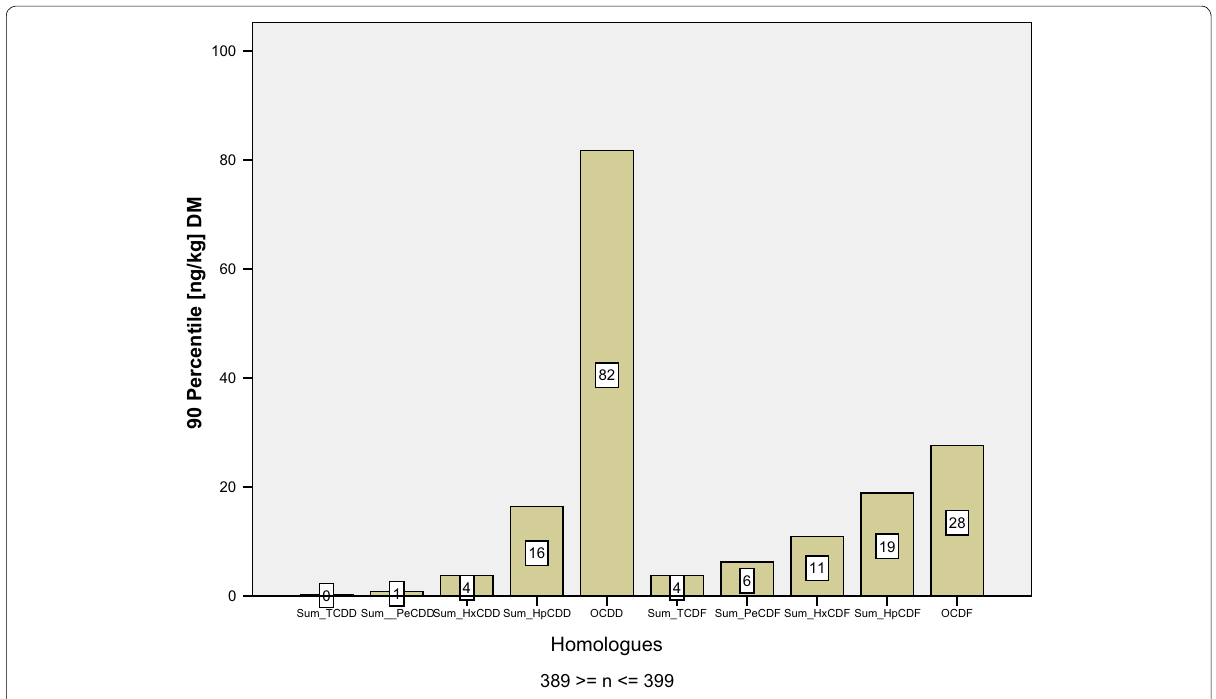
Fig. 6 Homologue pattern of 2,3,7,8-chlorine subsidized PCDD/F in Bavarian forest top soil layers (outlier eliminated)